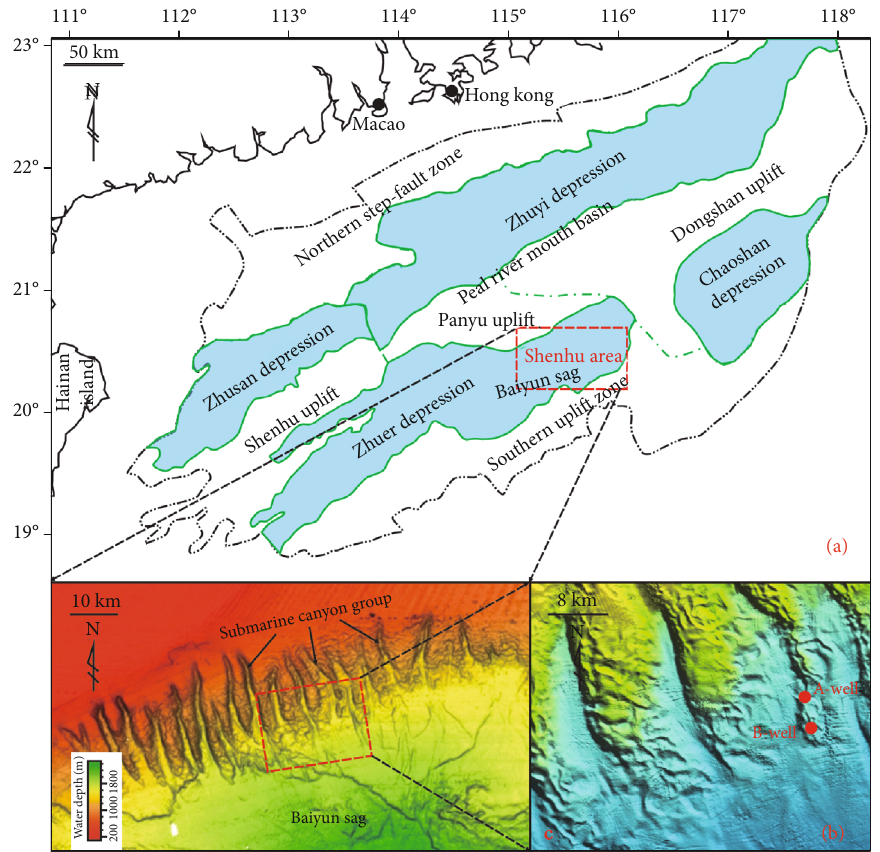
Figure 1: Regional geological background of the Shenhu area in the north of South China